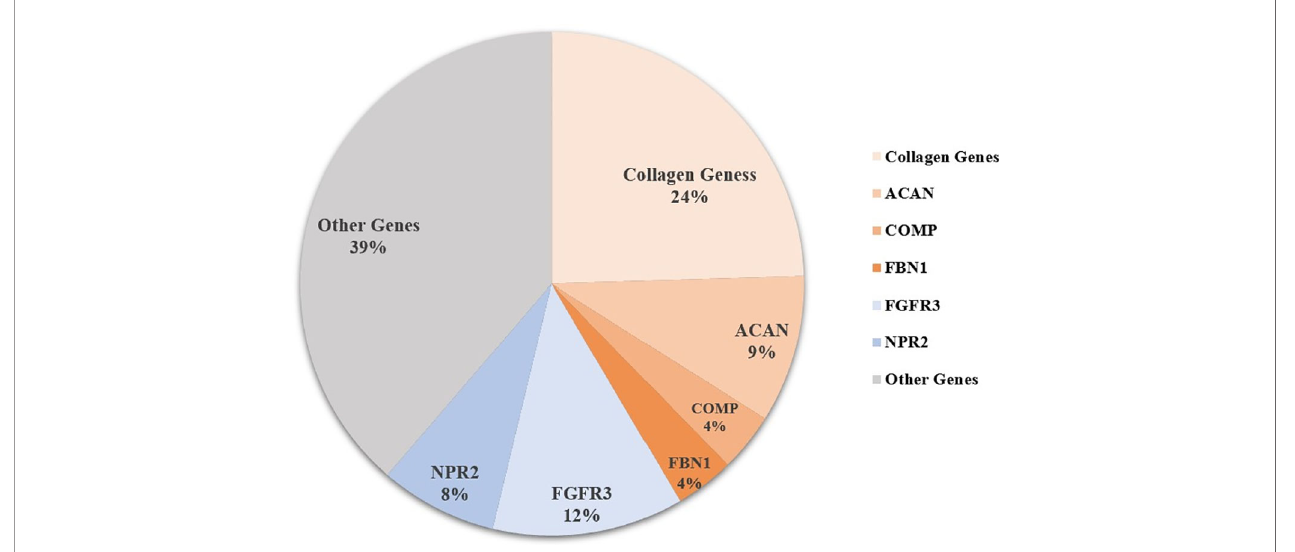
FIGURE 1 | Genetic architecture of short statue with skeletal abnormalities from a single center. Other genes include PTH1R, TRPV4, SHOX, KIF22, TRAPPC2, ARSL, RUNX2, CENPJ, FAM111A , CNV (copy number variant), and some unknown causative